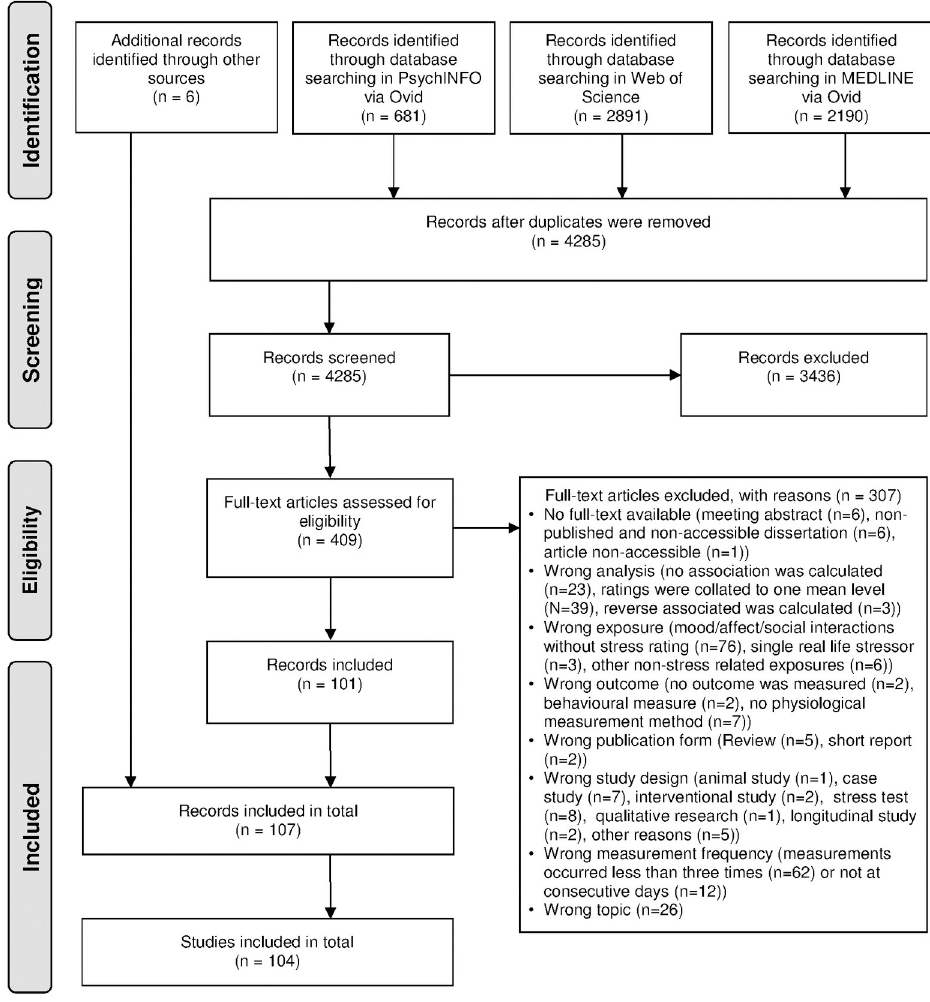
Fig 1. Flow chart of literature search (adapted from PRISMA guidelines